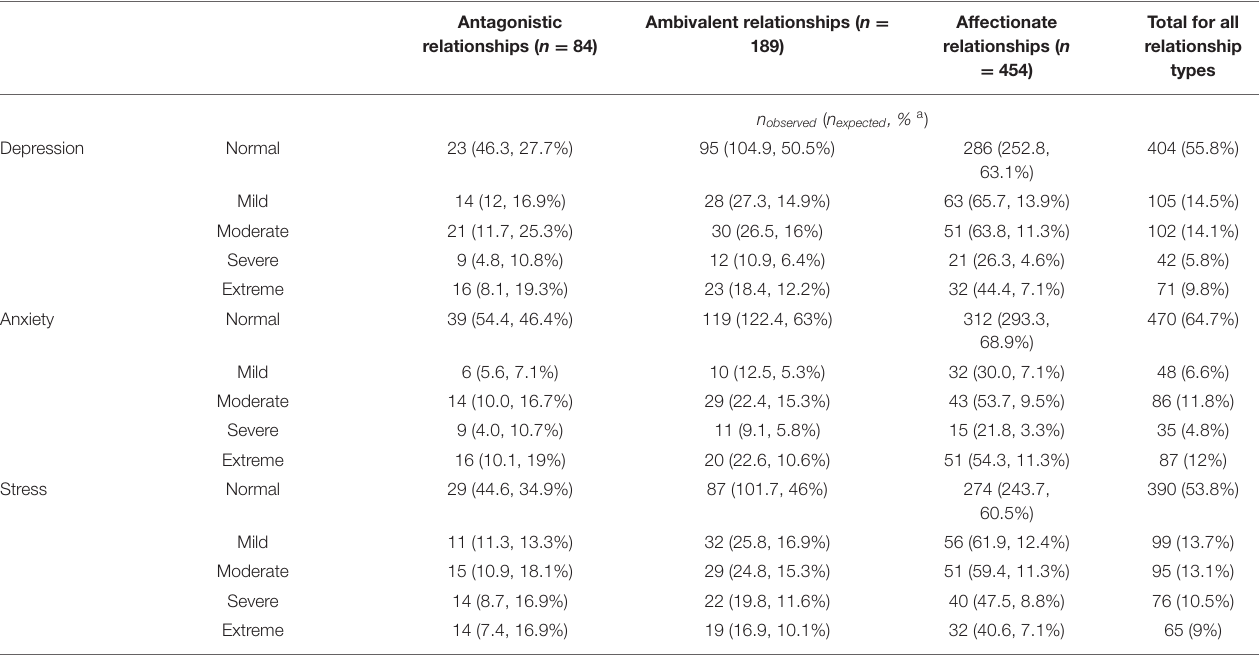
TABLE 6 | Prevalence of DASS-21 depression, anxiety, and stress levels in different relationship